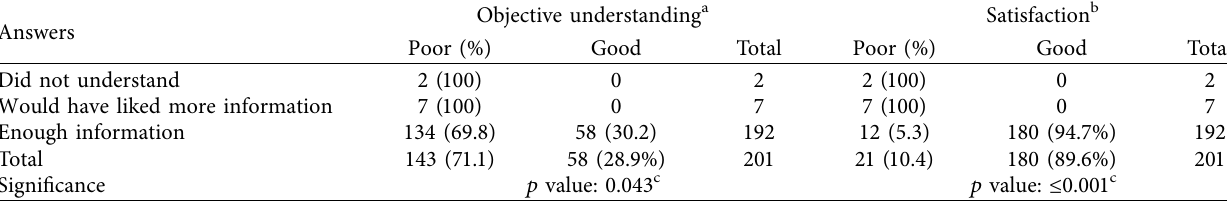
Table 5: Efect of patient’s subjective understanding on objective understanding and satisfaction.